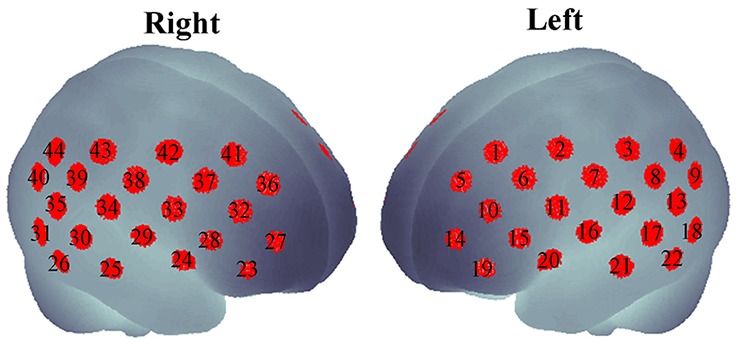
Forty-four channels spatially registered on bilateral hemispheres.